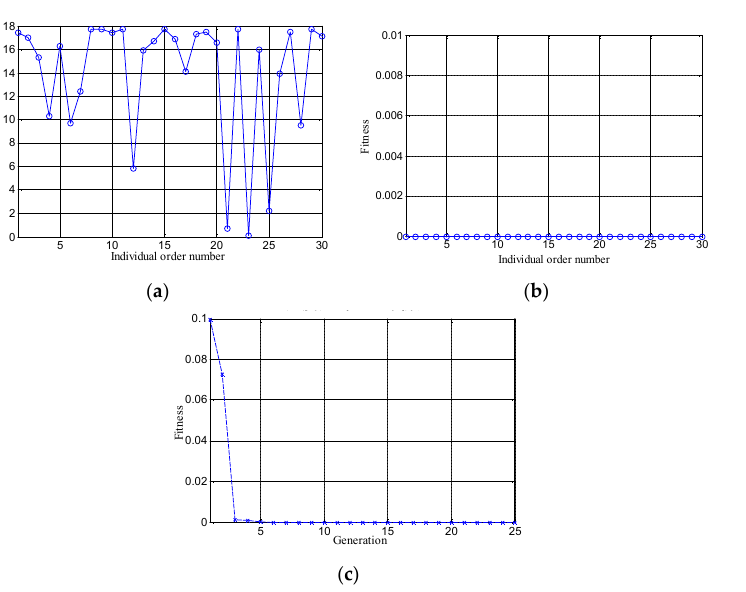
Figure 9. Fitness results of genetic algorithm optimized GRNN: ( a ) individual fitness of the first-generation population; ( b ) individual fitness of the final generation population; ( c ) fitness curve.